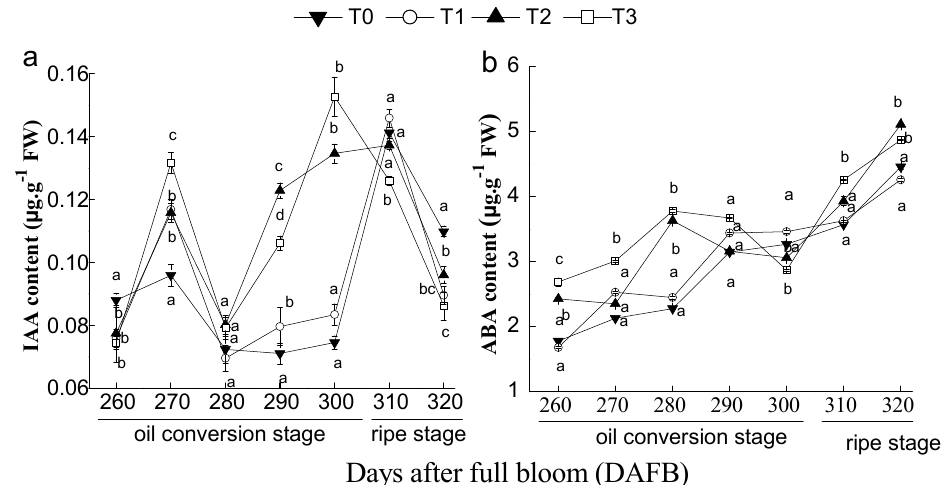
Figure 5. Changes in the endogenous hormones ( a ) abscisic acid (ABA) and ( b ) auxin (IAA) of C. oleifera fruit peel under different flower load treatments from 260 days after full bloom (DAFB) to 320 DAFB. Treatments: T0, removed 0% of the tree flowers; T1, removed 20% of the tree flowers; T2, removed 40% of the tree flowers; T3, removed 60% of the tree flowers. Values represent means ± S.E. ( n = 3). Different lowercase English letters (a, b, c and d) in the graph indicate significant differences between treatments ( p < 0.05). Table 4. Correlation coefficient between hormones and nutrient content of C. oleifera at oil conversion and fruit ripening stages.